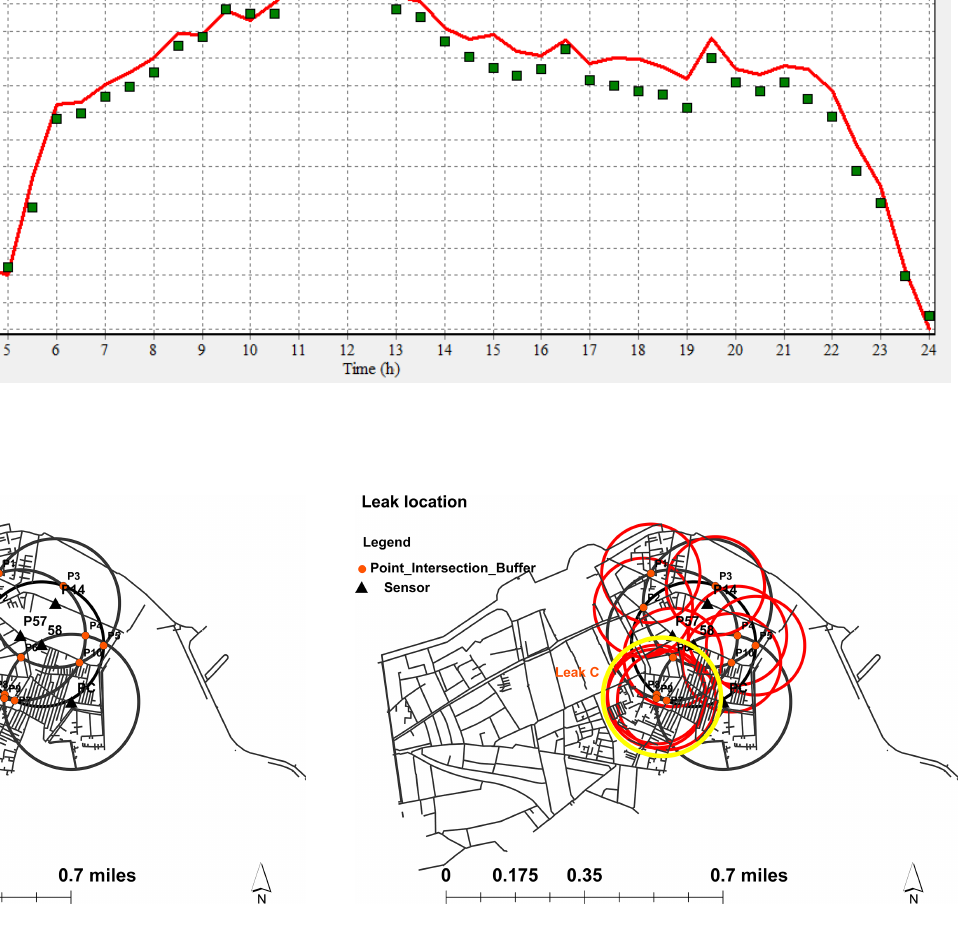
Figure 17. Spatial location of the leak LC. Please note that 1mi =